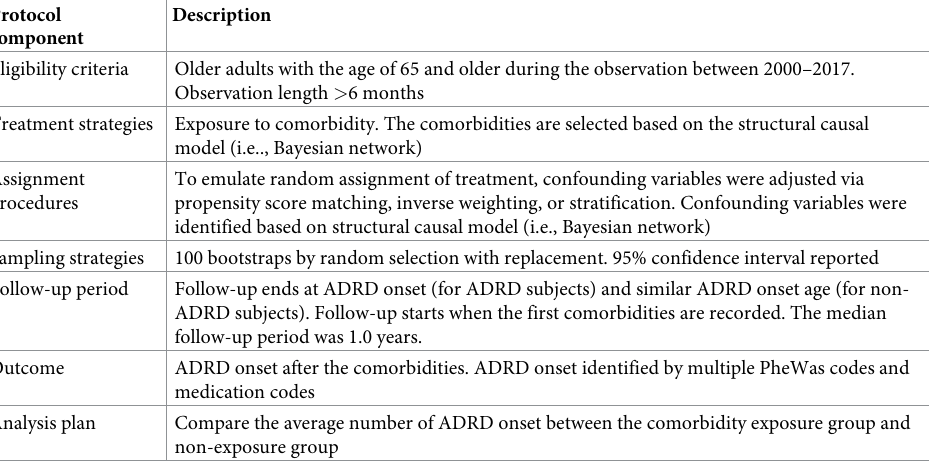
Table 1. Summary of the study design based on Target Trial framework [17]. We performed the analysis for Afri- can American and Caucasian counterparts, respectively. Protocol